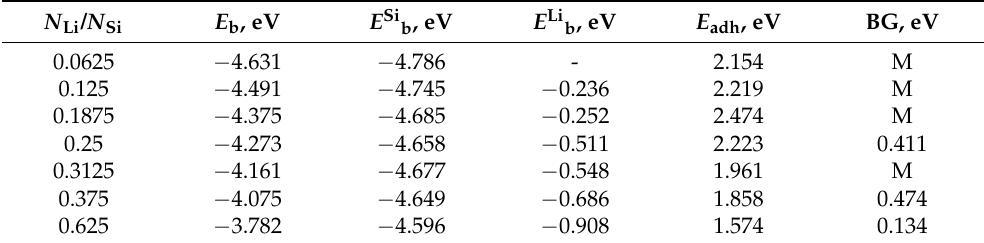
Table 1. Dependence of the energy characteristics * of a free-standing silicene sheet adsorbed by lithium on the number of deposited Li